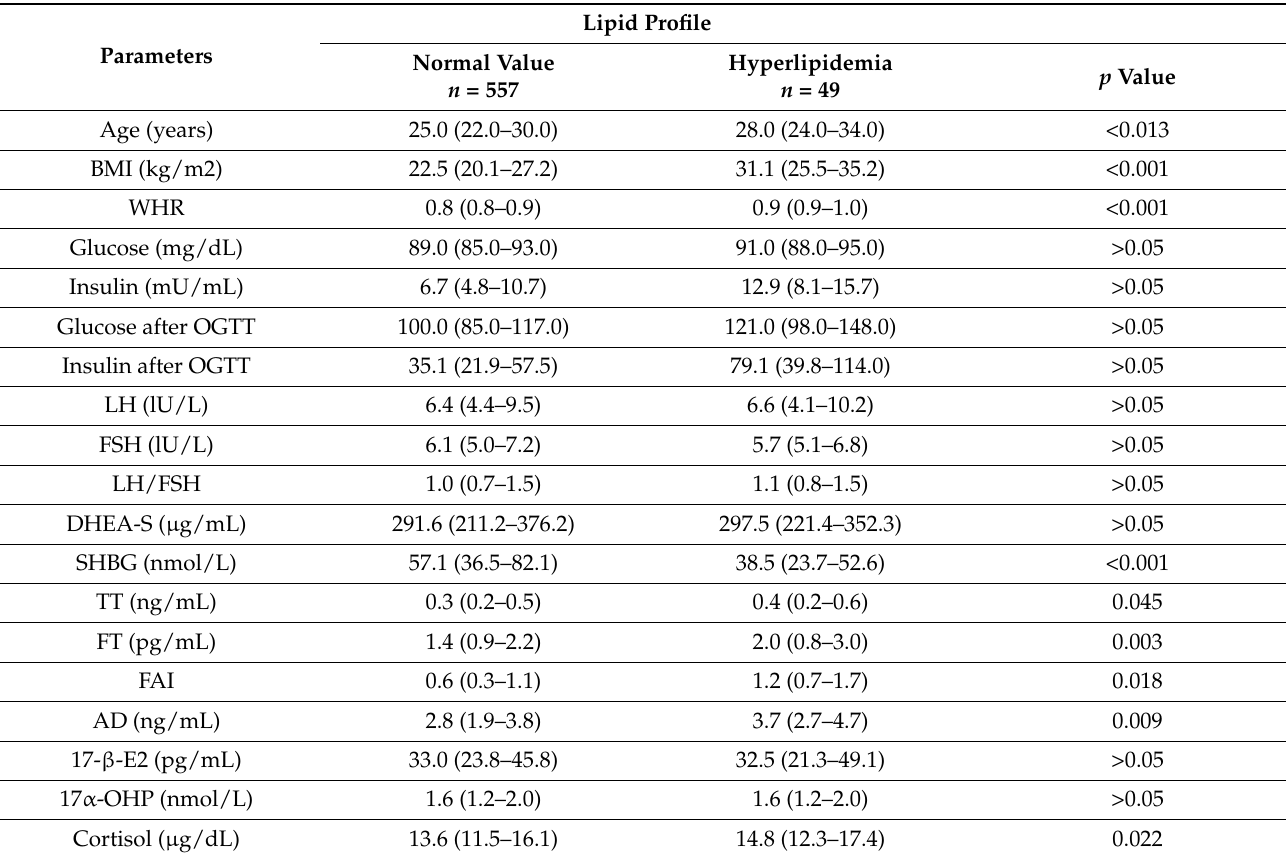
Table 3. Investigated parameters in the subgroups divided according to hyperlipidemia (CHO > 200.00 mg/dL and TG > 150